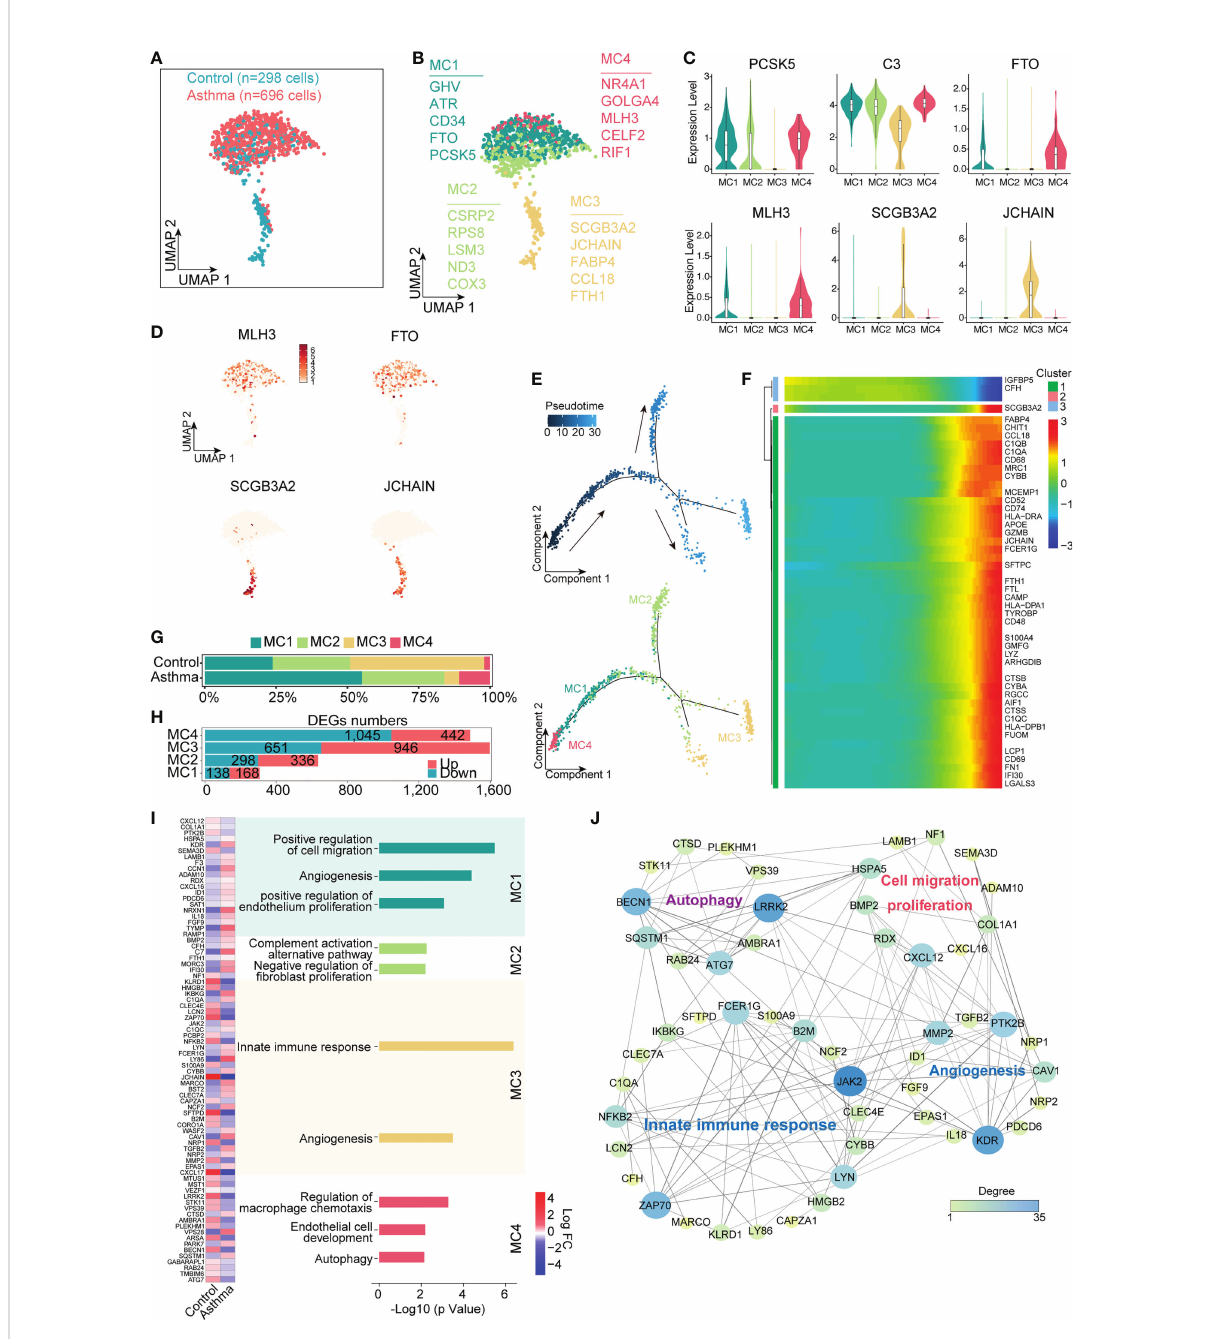
FIGURE 5 Mesenchymal cells participate in the regulation of airway remodeling and immune response in the lungs of the A.suum -induced asthma. (A) , UMAP visualization of all scRNA-seq data of mesenchymal cells in control and asthma groups. Captured cells: control = 298, asthma = 696. (B) , Four clusters (subtypes) of mesenchymal cells are colored and labeled according to their inferred cell type identities. (C) , Violin plots assessment of signature gene expression in each subtype. (D) , UMAP visualization of unique gene expression speci fi cally distinguishes each cluster MC1 and MC4 (MLH3 and FTO), MC3 (SCGB3A2 and JCHAIN). (E) , Pseudotime developmental trajectory analysis from MC depicting how each of the MC1, MC2, MC3 and MC4 subsets relate to each other. Trajectory directions were determined by biological prior. (F) , Heatmap showing scaled expression of dynamic genes along the pseudotime, and these genes were clustered into three groups according to their expression pattern along the pseudotime. (G, H) , Representation of the cell numbers proportion and DEG numbers of control and asthma in each subtype. (I) , Representation of signi fi cant GO and KEGG analysis associated with mesenchymal and heatmap showing the differential genes in biological processes between control and asthma. (J) , Visualization of gene regulatory network analysis between cell subsets. Interactions between genes are shown as edges. Node sizes and shades of color re fl ect the degree of centrality and strength of